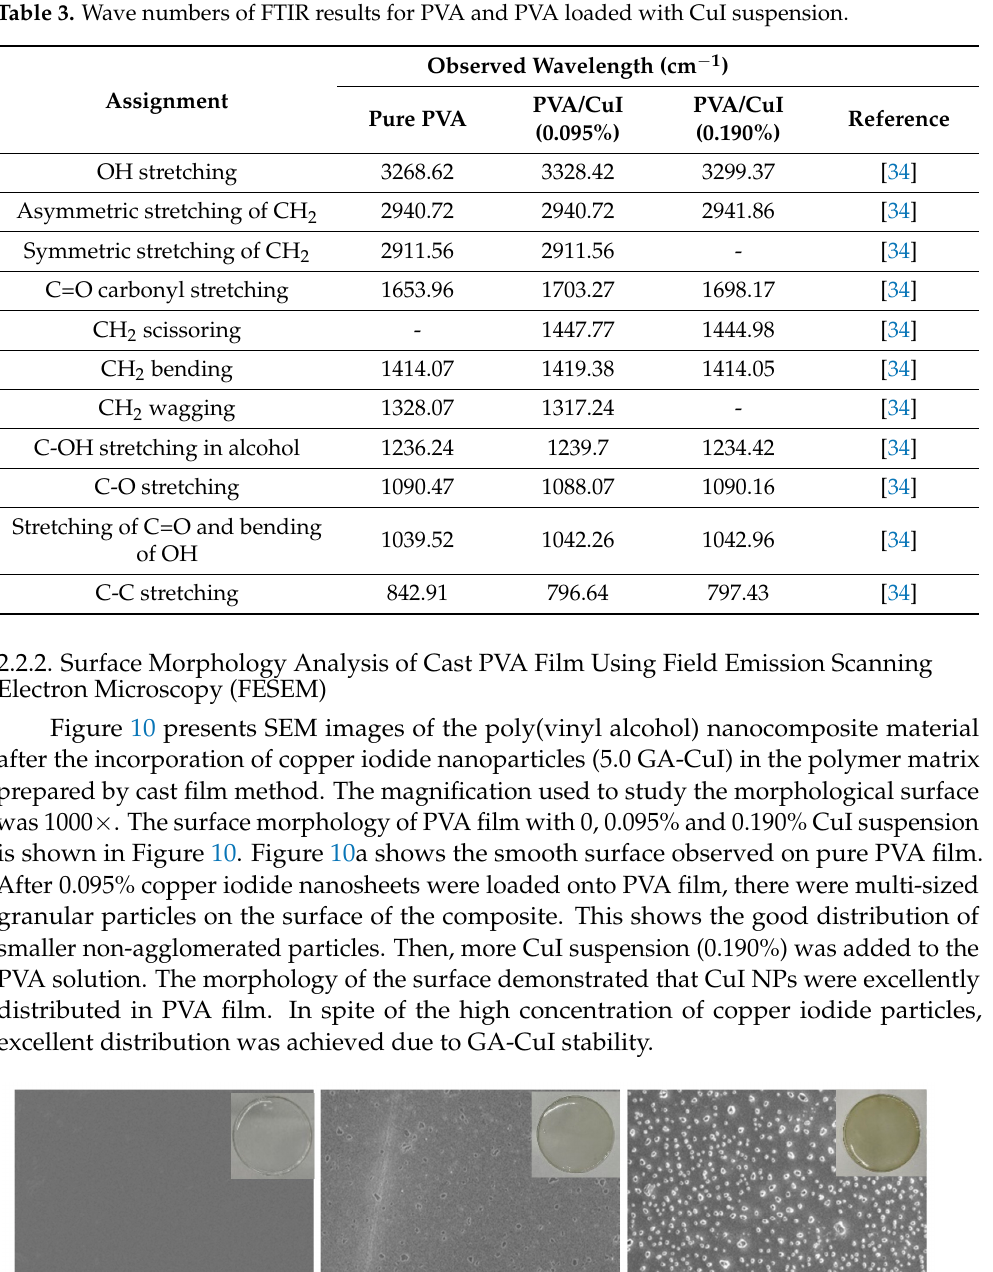
Table 3. Wave numbers of FTIR results for PVA and PVA loaded with CuI suspension.